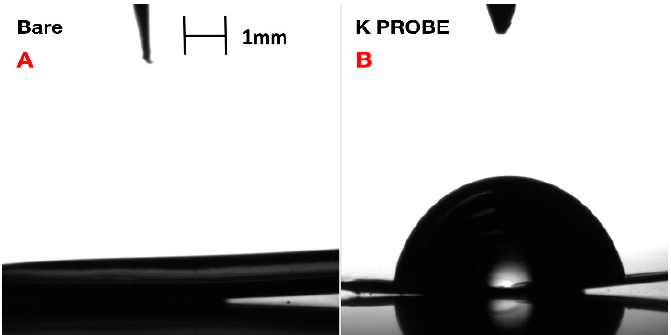
Figure 3. Contact Angle Geometry for ( A ) bare cleaned gold pads and ( B ) mixed monolayer coated gold pads. Heavy and light phase were measured using deionized water and air, respectively.